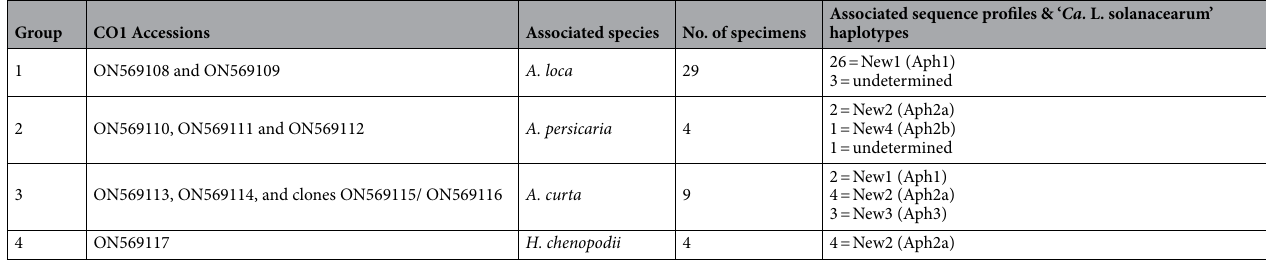
to its numerical presence on cards (Table 5). The host plant of this psyllid in the study region appears to be the